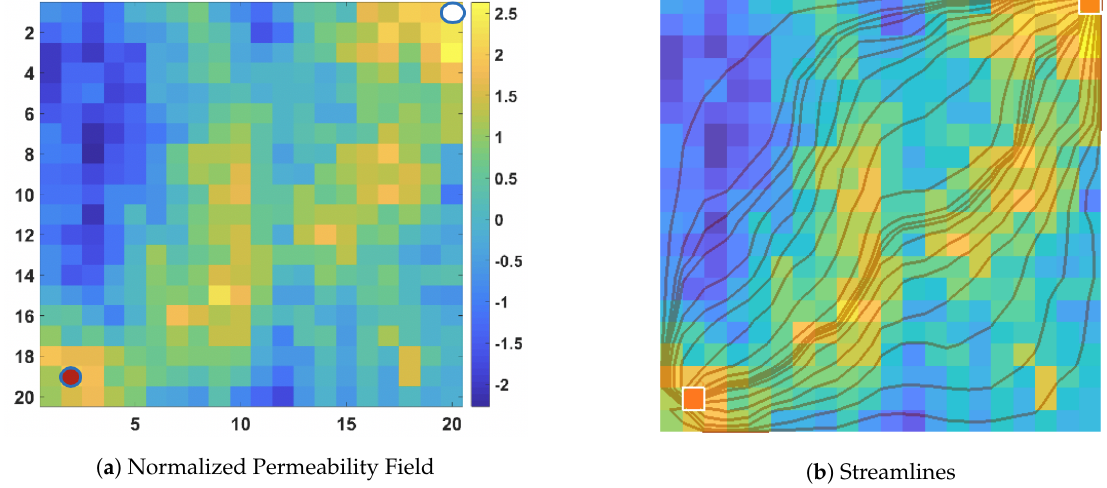
Figure 2. ( a ) Heterogeneous channelized permeability field with one producer in red and one injector in white ( b ) Streamlines imposed on the permeability